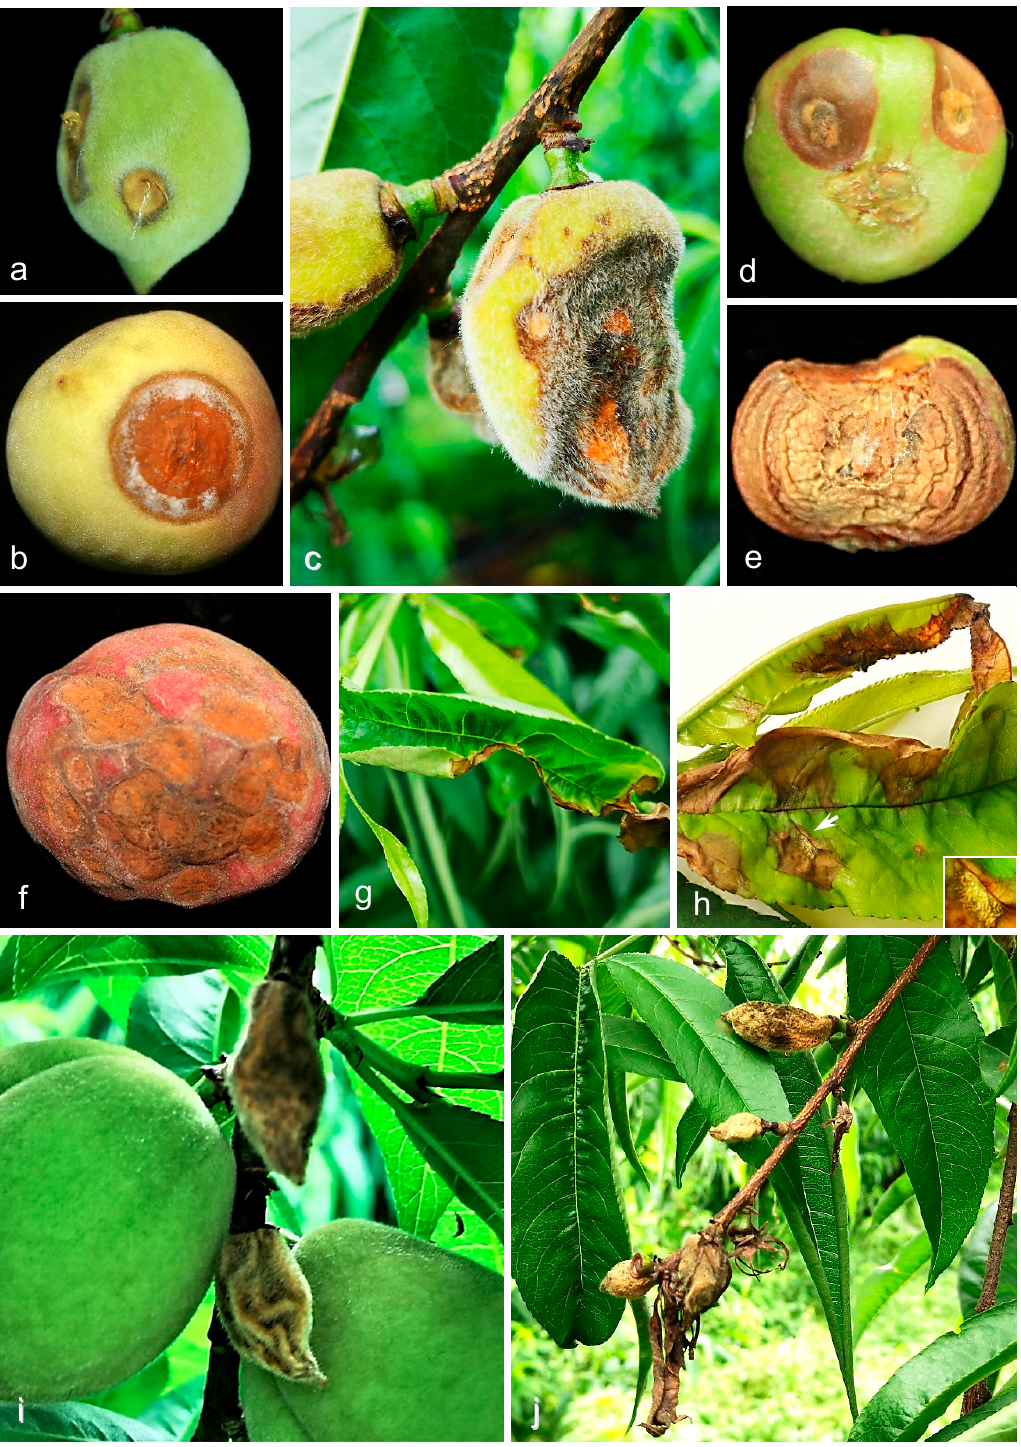
Figure 1. Symptoms of peach anthracnose on fruit and leaves. ( a – f ) Various symptoms on fruit of Prunus persica ( a – c , f ) and P. persica var. nucipersica ( d , e ): ( a , c – e ) lesions on fruitlets and ( b , f ) lesions on mature peach fruit; ( g , h ) anthracnose symptoms on leaves; ( i ) mumified young fruit; ( j ) infected